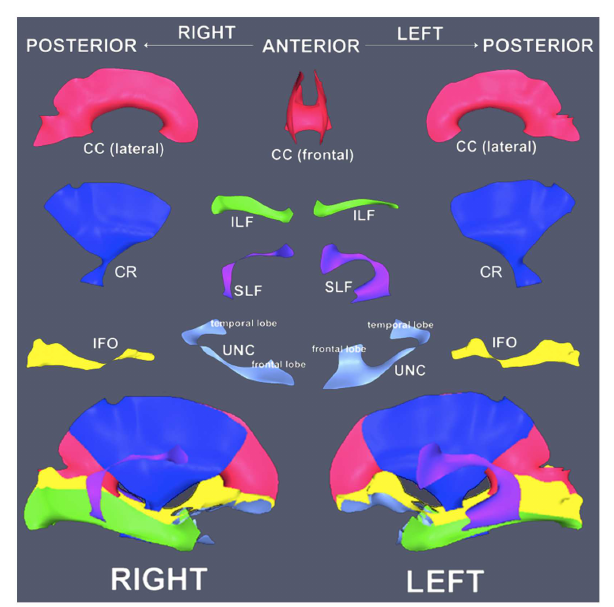
FIGURE 1 | Orientation diagram of white matter tract models .Tract models are presented in corresponding arrangement to the visualizations of the results (top).Tract models are assembled in anatomical context (bottom). Note the UNC models are rotated in the isolated view relative to the anatomical arrangement to display the surface more effectively. CC, corpus callosum; CR, corona radiata; ILF, inferior longitudinal fasciculus; SLF, superior longitudinal fasciculus; IFO, inferior fronto-occipital fasciculus; UNC, uncinate